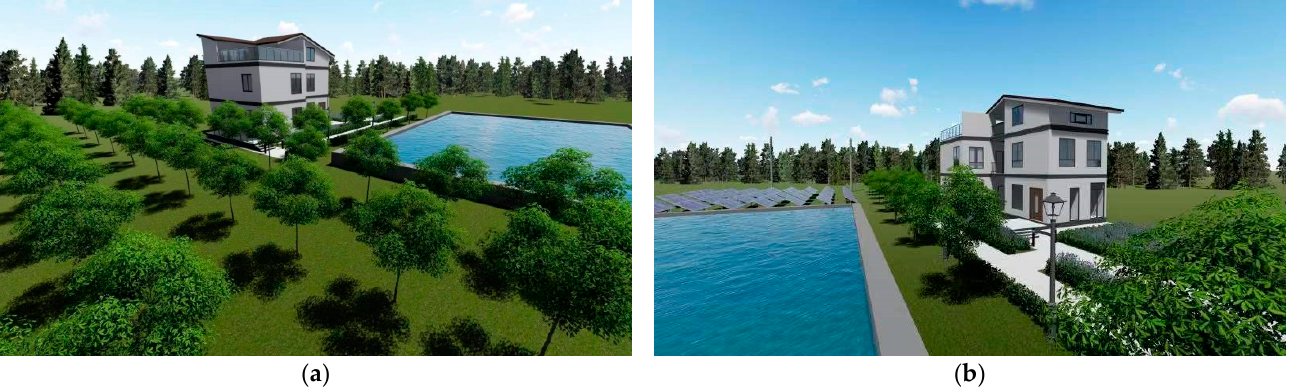
Figure 6. 3D simulated pictures of the residential houses for validation of the DAFuzzy model in this study. ( a ) House 1, ( b ) House 2.